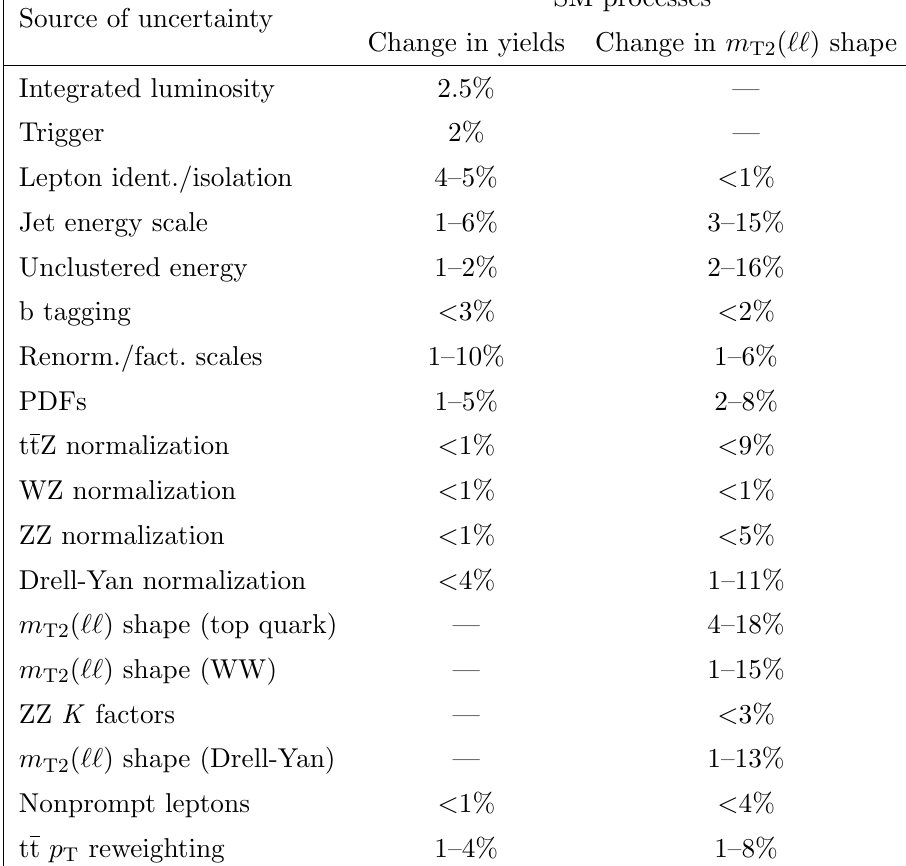
Table 5 . Sizes of systematic uncertainties in the predicted yields for SM processes. The (cid:12)rst column shows the range of the uncertainties in the global background normalization across the di(cid:11)erent SRs. The second column quanti(cid:12)es the e(cid:11)ect on the m T2 ( ‘‘ ) shape. This is computed by taking the maximum variation across the m T2 ( ‘‘ ) bins (after renormalizing for the global change of all the distribution) in each SR. The range of this variation across the SRs is given. upper limits with pp ! (cid:31) + 1 e